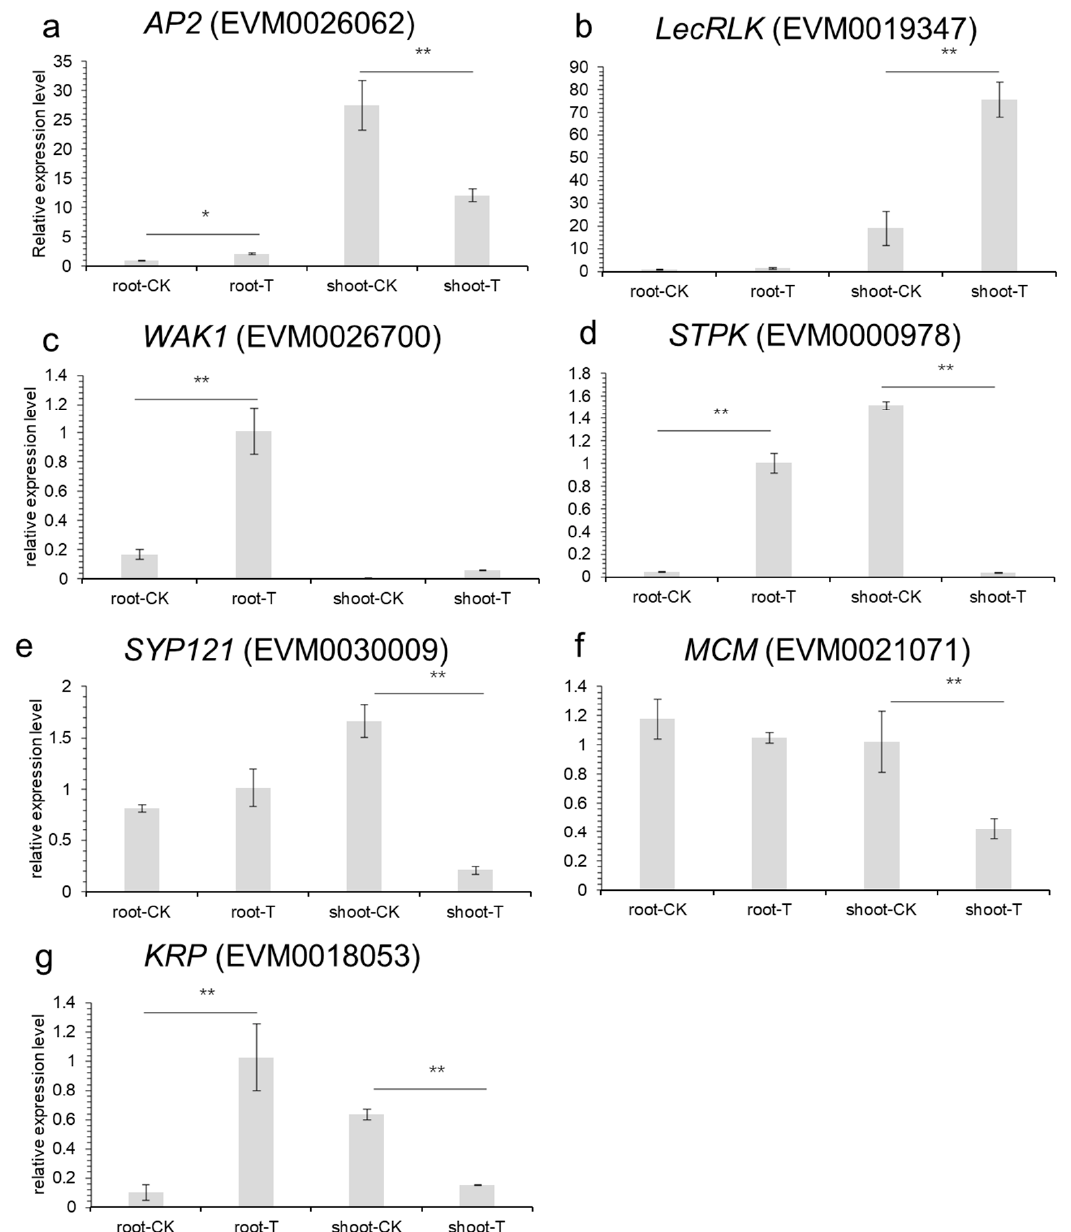
Figure 5. The expression trends of the gravity responses-related genes in the roots and shoots. The qRT–PCR analysis of the transcript levels of the candidate genes in the roots and shoots under the two conditions. The Y -axis represents the relative expression level, while the X -axis represents the different cultivars. The error bars denote the standard error (SE). The expression level was significantly different at * p < 0.05 and ** p < 0.01.